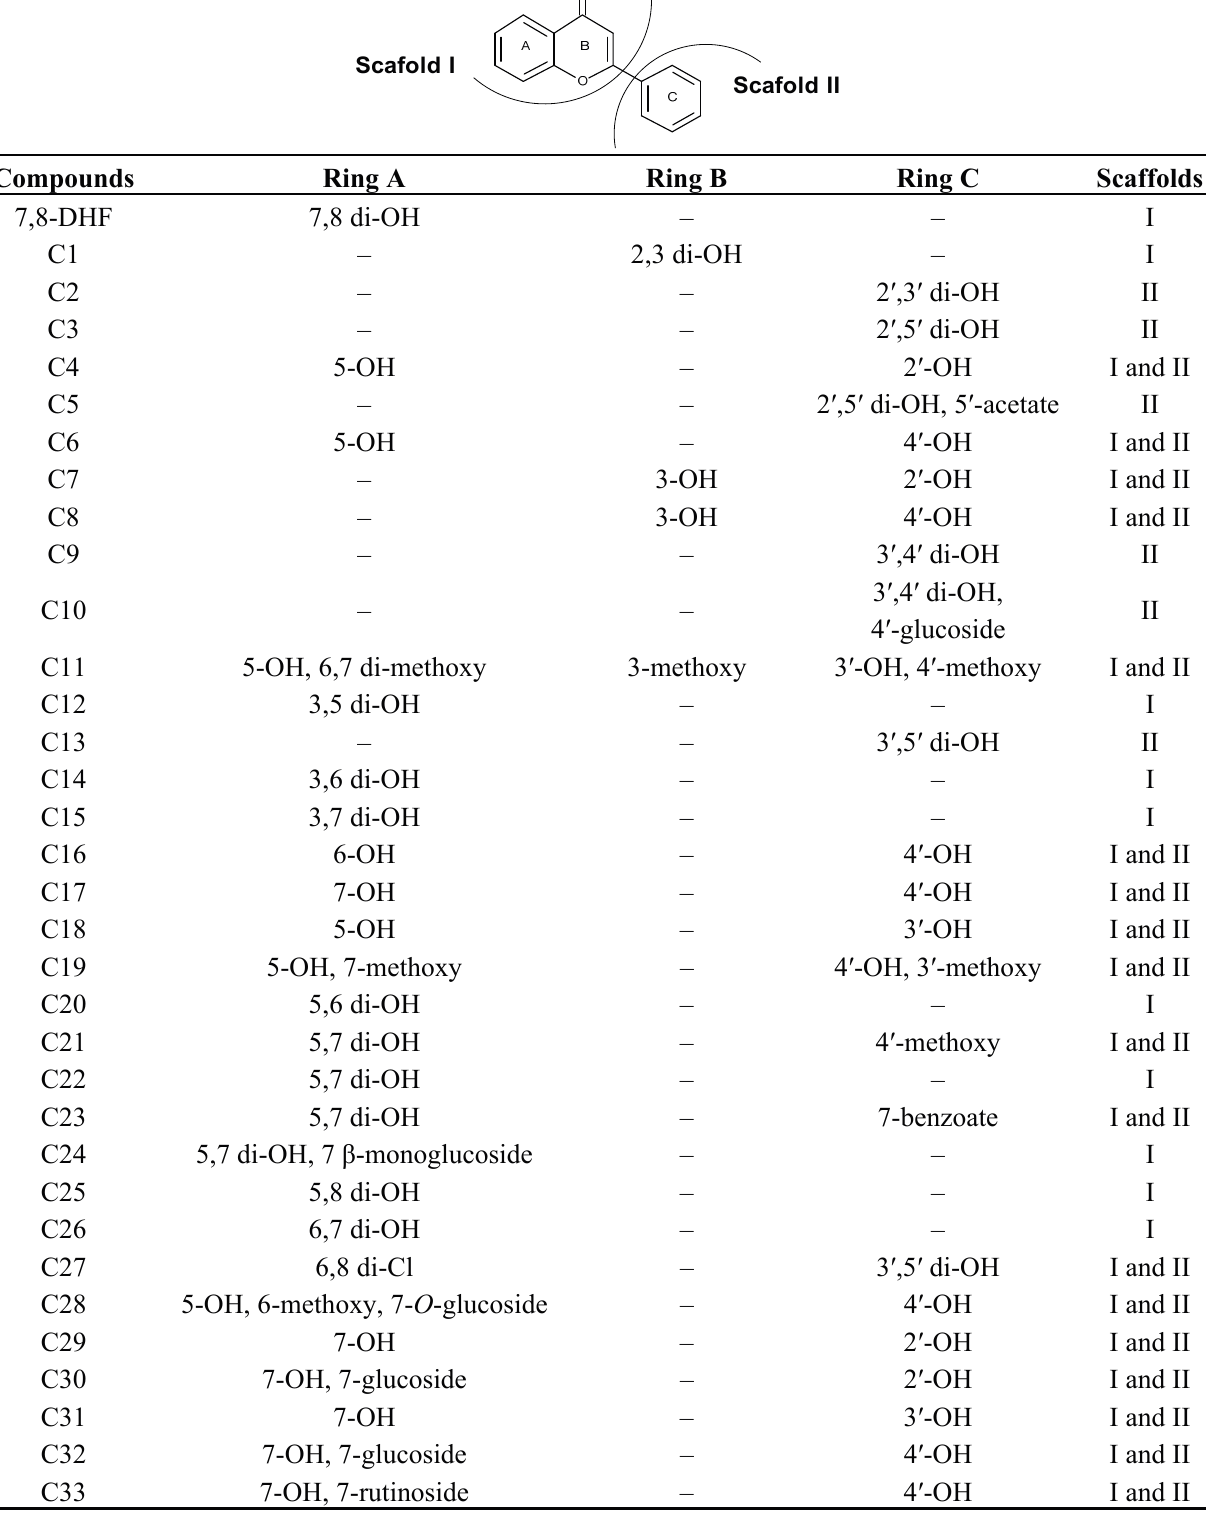
Table 1. Structural parameters of thirty-seven di-hydroxy flavonoid derivatives including 7,8-DHF.